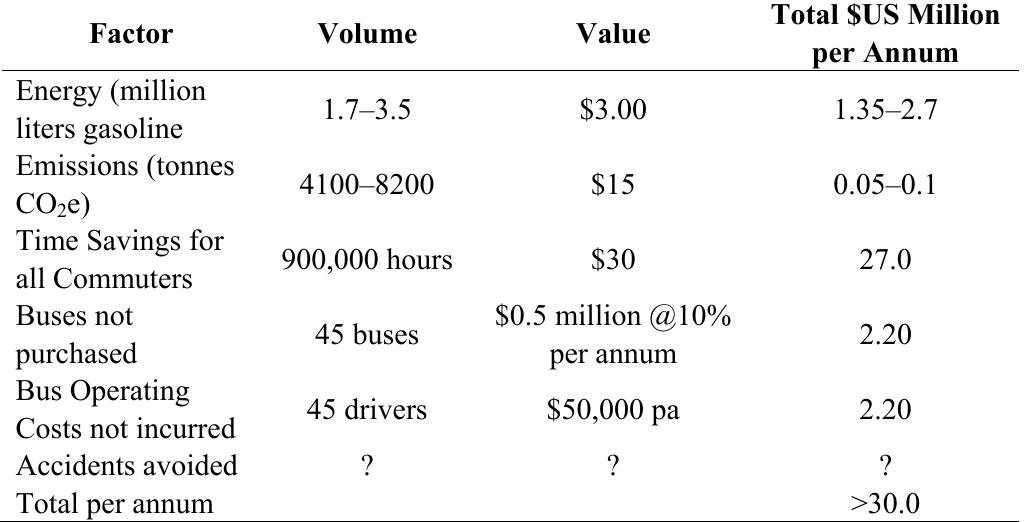
Table 4. Estimate of Annual Savings from Casual Carpooling in San Francisco. All volumes and values in Table 4 have been estimated by the